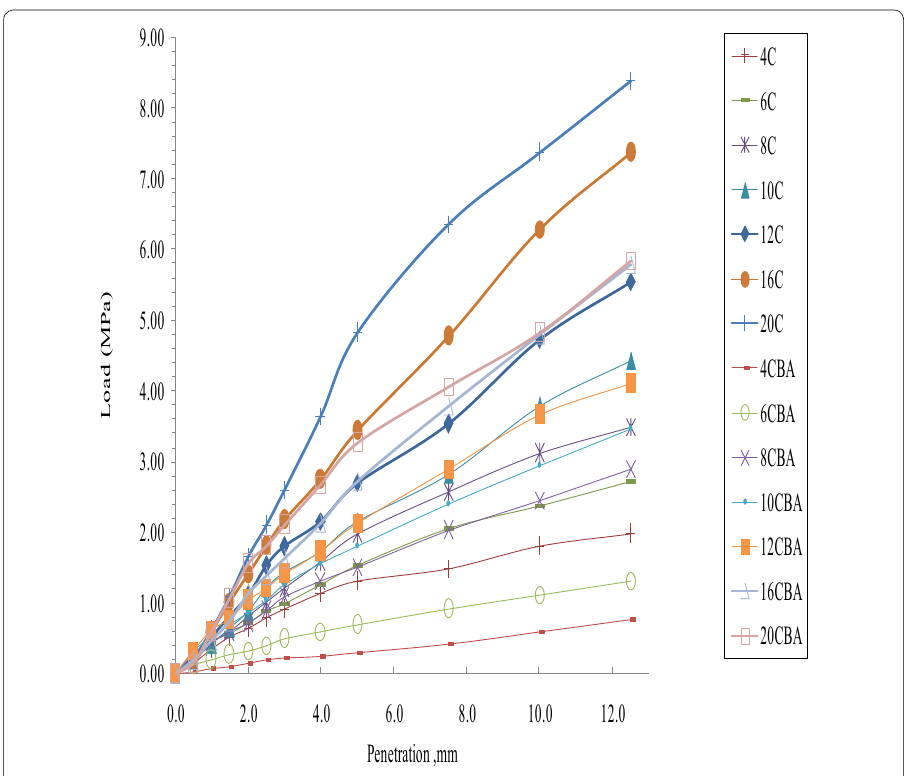
Fig. 7 Load-penetration test results at different cement and cement–bottom ash contents